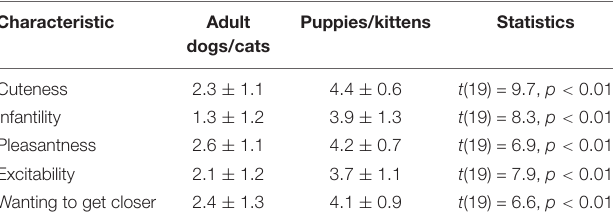
TABLE 1 | Ratings of the seven images of adult dogs/cats and the seven images of puppies/kittens that were chosen for the main study. Characteristic Adult dogs/cats